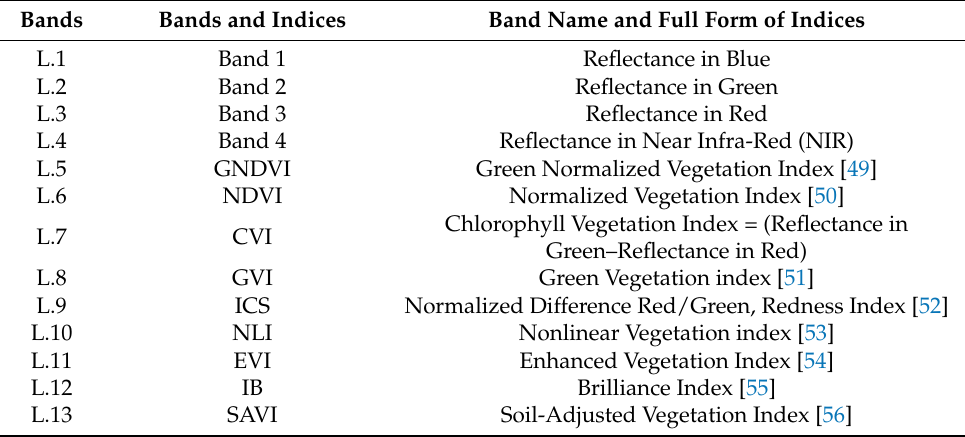
Table 2. SPOT 7 satellite image bands and the 9 indices used for random forests